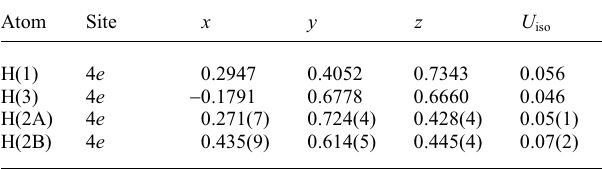
Table 2. Atomic coordinates and displacement parameters (in Å 2 )